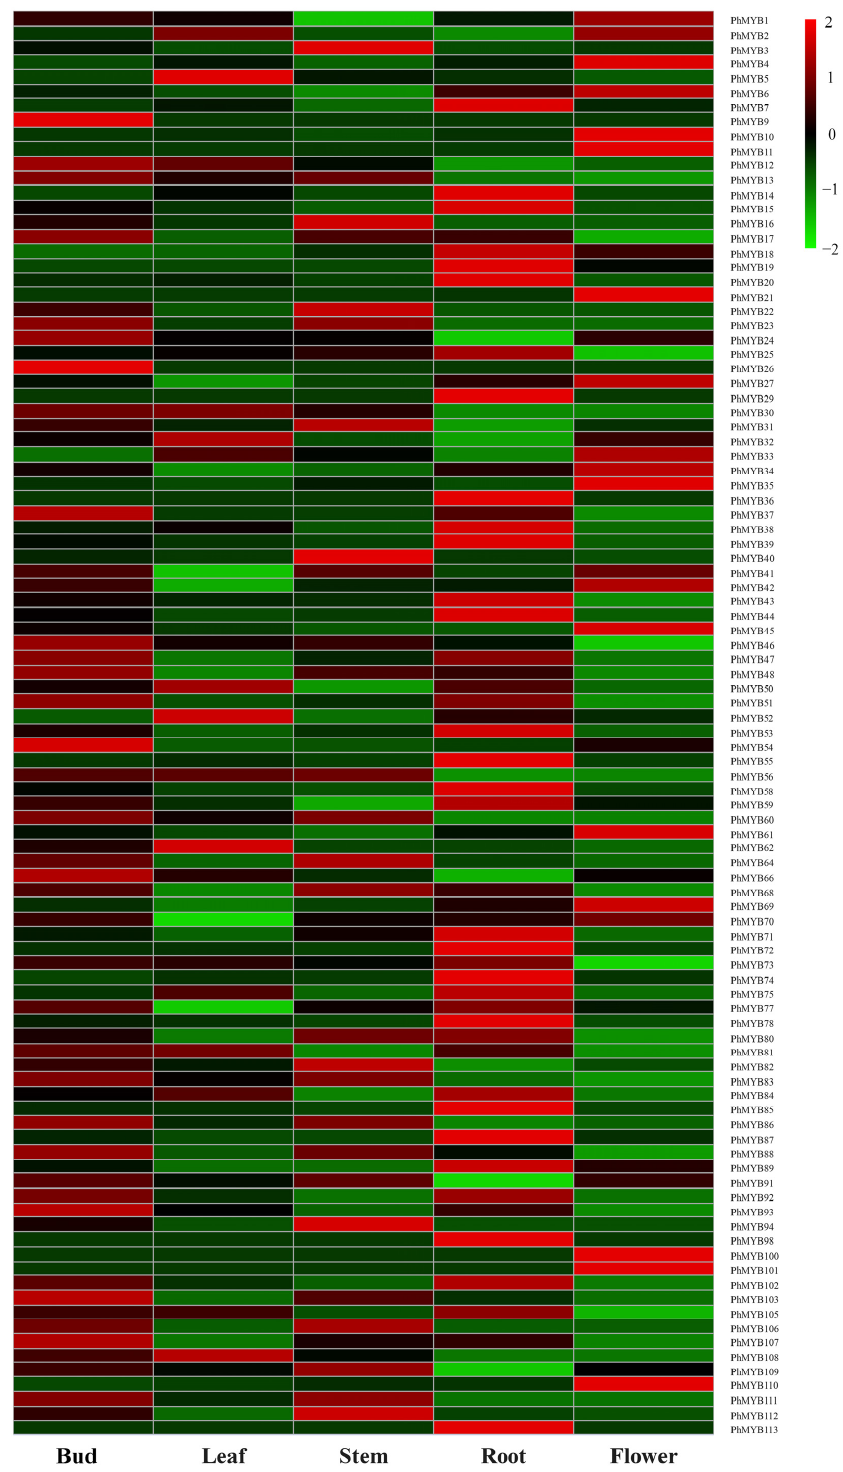
Figure 2. Petunia R2R3-MYB gene expression in different tissues. The R2R3-MYB gene expression levels in the roots, stems, leaves, flowers, and buds is depicted by a heat map. The tissue with the greatest gene expression level was judged to have a gene expression level of two. Blocks with colors represent changes in transcript accumulation relative to the corresponding control, either decreasing (green) or increasing